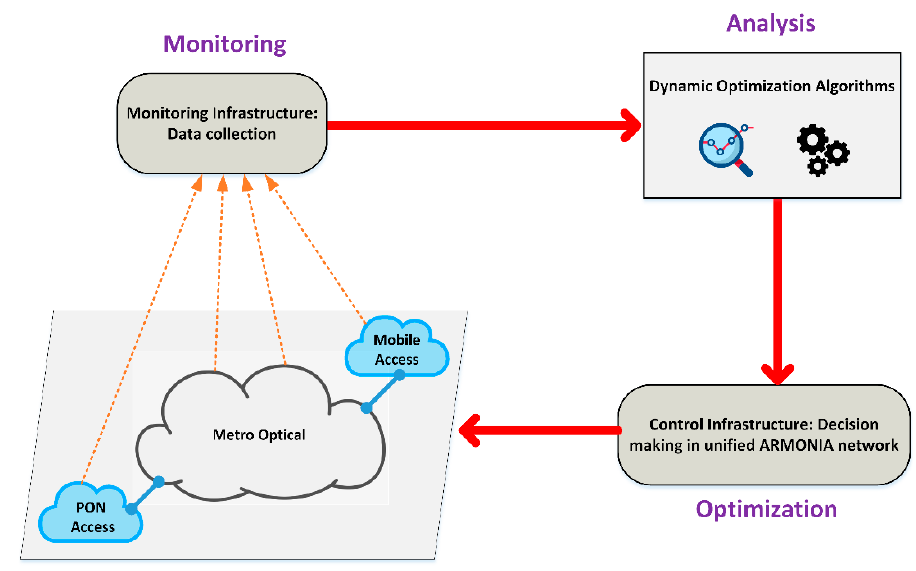
Figure 1. ARMONIA’s closed control loop.